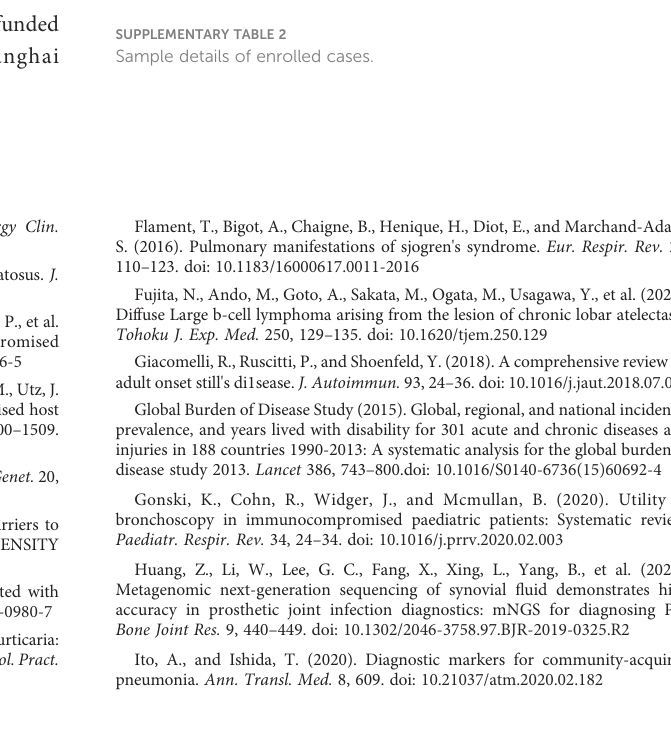
SUPPLEMENTARY TABLE 1 Conventional microbiological methods used in the study. SUPPLEMENTARY TABLE 2 Sample details of enrolled